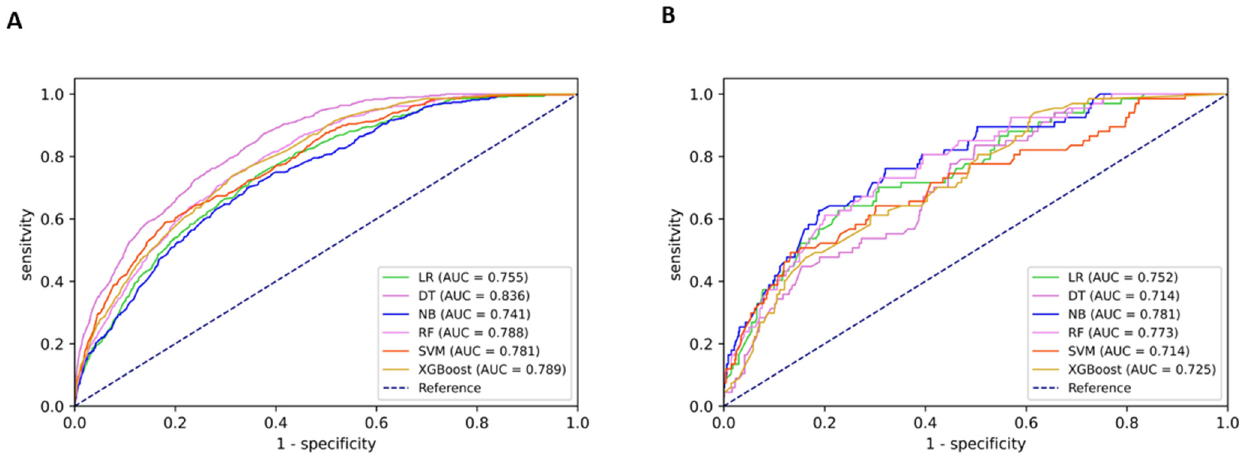
Figure 3. Performance of different models for detecting HSIL+ among patients diagnosed as <HSIL by colposcopists. Displayed are receiver operating characteristic (ROC) curves and the area under the curves (AUC) of different models in detecting histologically confirmed high-grade squamous intraepithelial lesions or worse (HSIL+) with colposcopic impression <HSIL. Different colors represent different models. LR, logistic regression; SVM, support vector machine; DT, decision tree; NB, naïve bayes; RF, random forest; XGBoost, extreme gradient boosting. ( A ) internal validation; ( B ) external validation.